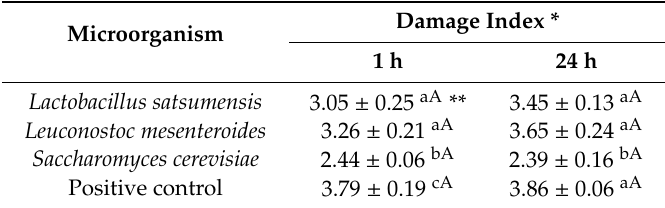
Figure 6. Comet tails of 24 h treatment of lymphocytes with H 2 O 2 and isolated strains. ( A ) L. mesenteroides , ( B ) L. satsumensis , ( C ) S. cerevisiae , ( D ) negative control (suspension containing only lymphocytes) and ( E ) positive control (suspension containing lymphocytes and hydrogen peroxide). Table 2. DNA damage index by H 2 O 2 after 1 and 24 h of Lactobacillus satsumensis LPBF1, Leuconostoc mesenteroides LPBF2 and Saccharomyes cerevisiae LPBF3